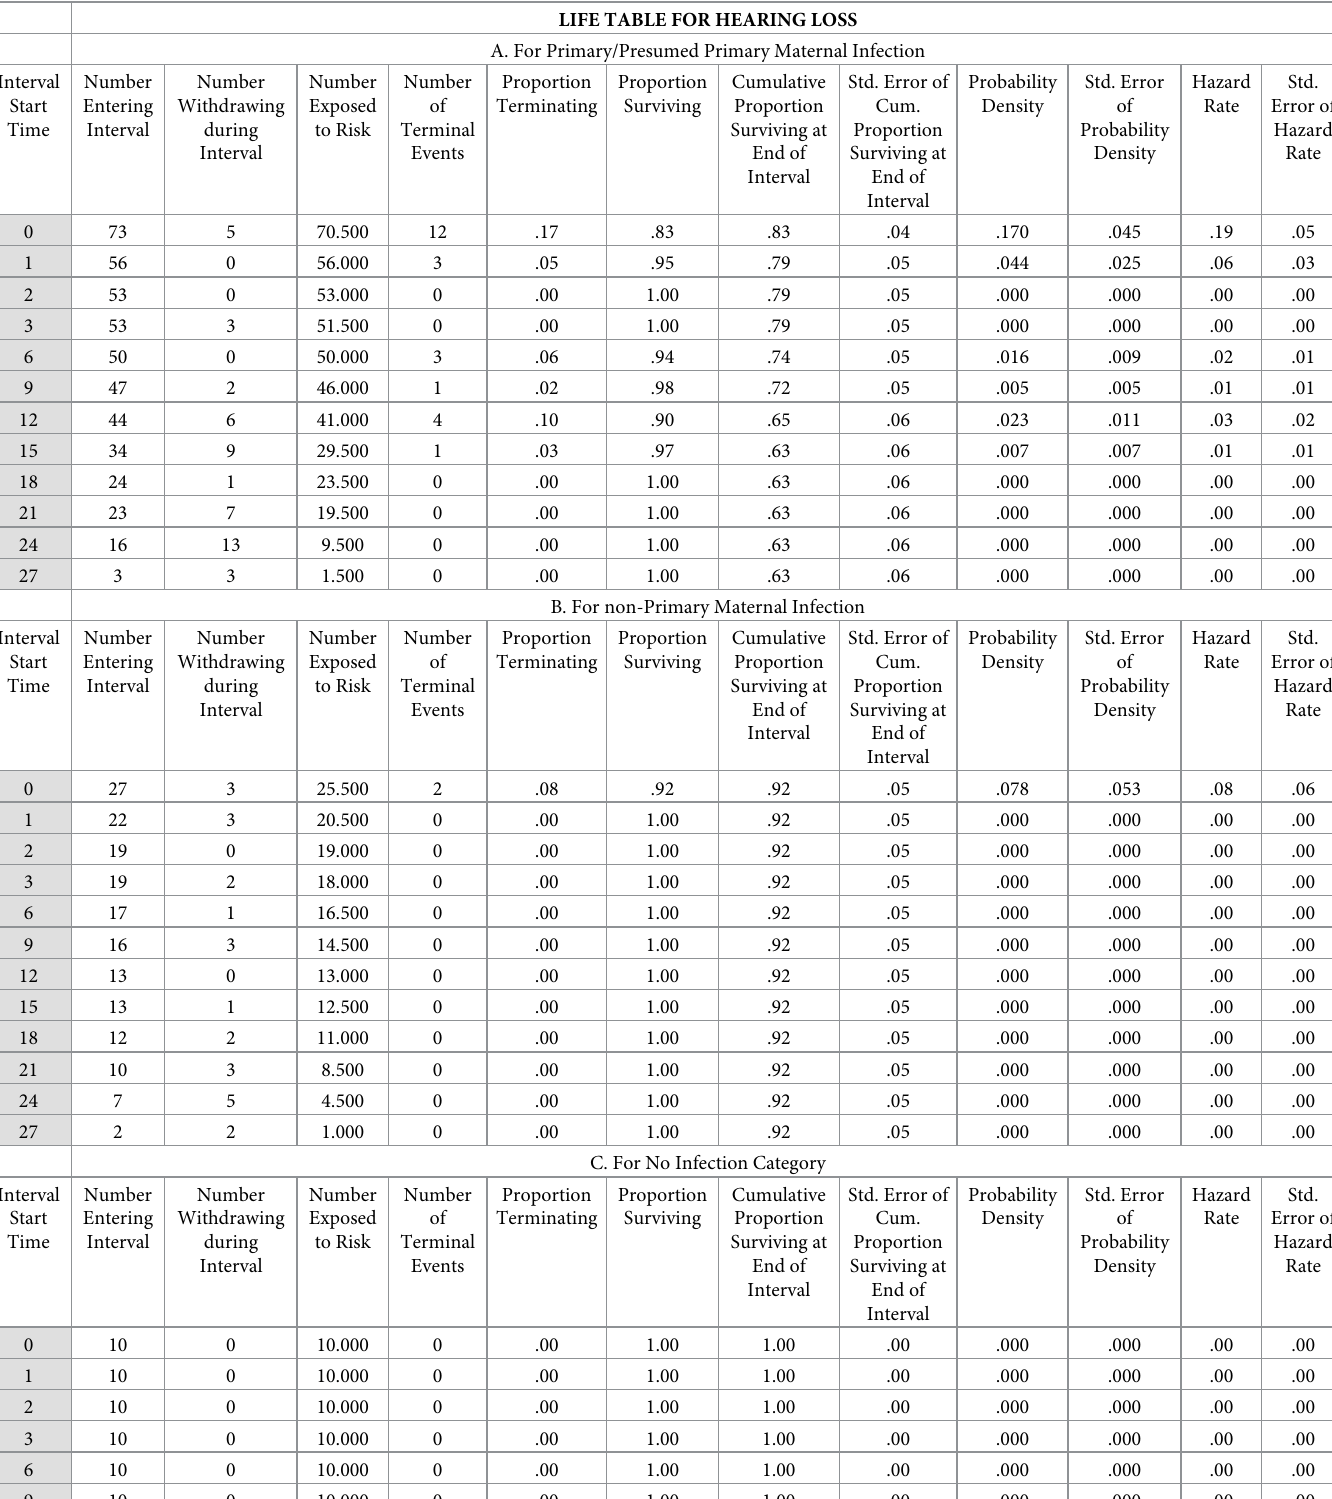
Table 4. Life tables for hearing loss in the child according to type of maternal CMV infection during pregnancy. LIFE TABLE FOR HEARING LOSS A. For Primary/Presumed Primary Maternal